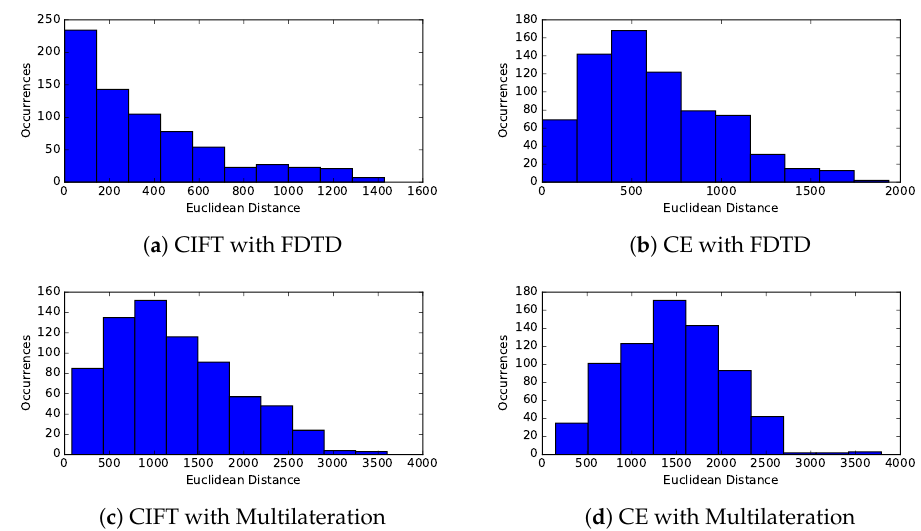
Figure 15. Error distribution (histogram) of PD events from DL23. The horizontal axis is the computed error. Each occurance is from one simulated PD event from a FDTD cell. The average error using CIFT with FDTD is about 340 mm, which is close the FDTD mesh size of 300 mm and smaller than other methods tested. All methods have some cases with large errors that require further